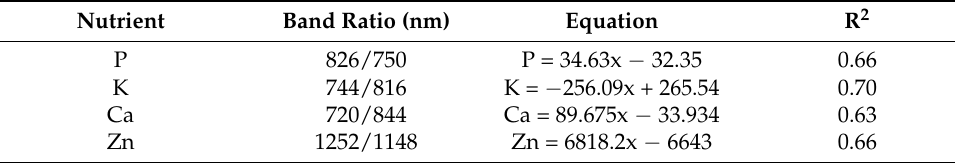
Table 3. Models for estimating leaf nutrient content using spectral band